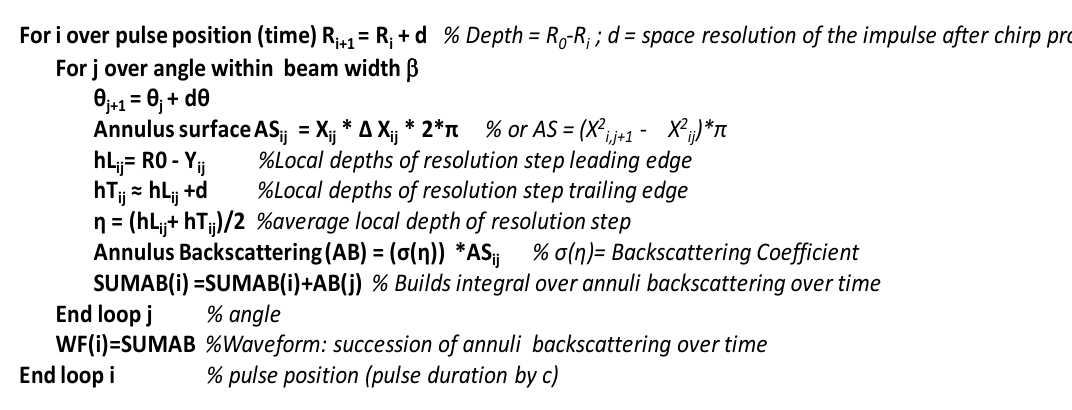
Figure 3. Simulation procedure for altimeter waveform: pseudo-code (comment in